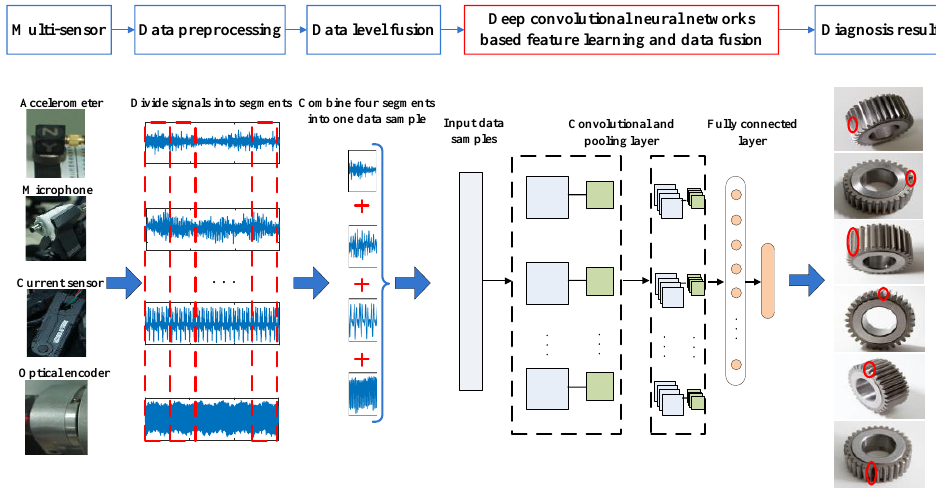
Figure 2. Flowchart of the proposed method.